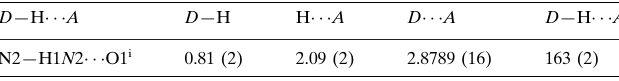
Hydrogen-bond geometry (A˚ , (cid:3)